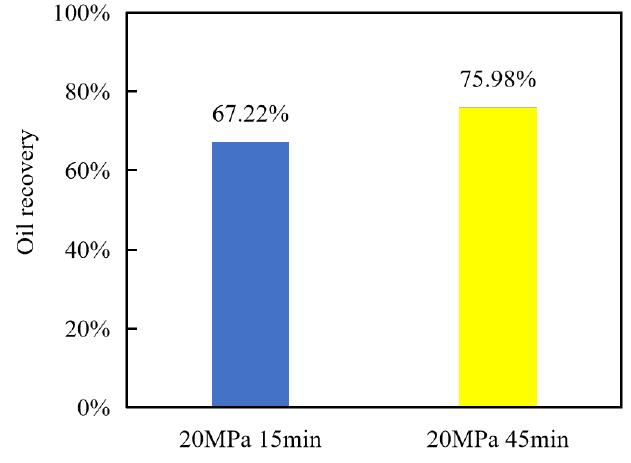
Figure 17. Relationship between recovery degree and soaking.